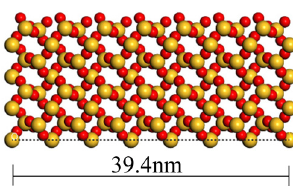
Figure 6: Section of SiO 2 molecular crystal.